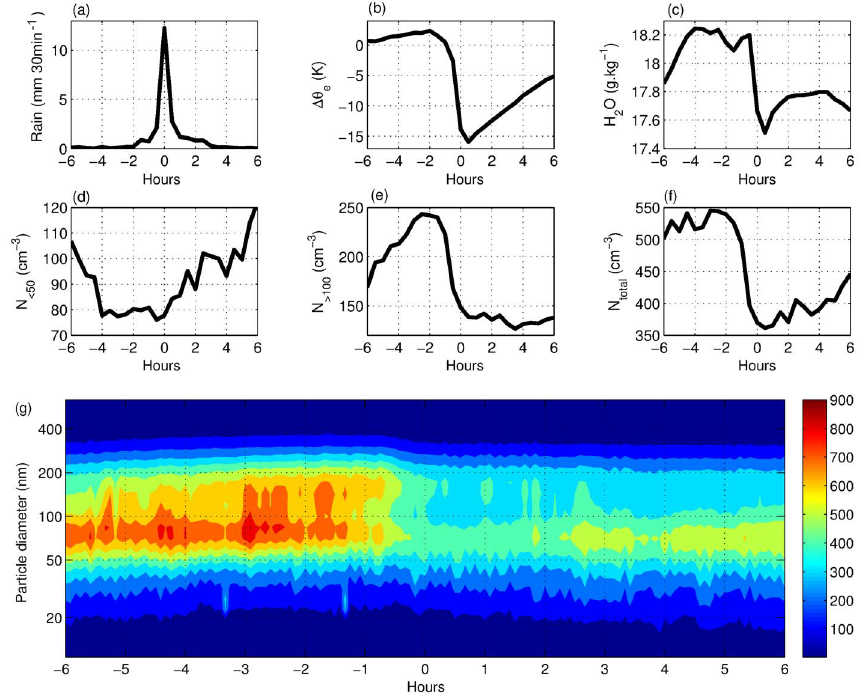
Figure 8. Mean values calculated within ± 6h of the occurrence of strong precipitation events ( > 10mmh − 1 ). Time zero corresponds to the instant of maximum precipitation in each event. Only wet season afternoon events (12:00–16:00LT) were considered in this plot. Top: (a) precipitation (accumulated mm in 30min), (b) variations in equivalent potential temperature ( (cid:49)θ e ), (c) H 2 O mixing ratios. Middle: (d) number concentration of particles with a diameter less than 50nm ( N < 50 ), (e) number concentration of particles with a diameter greater than 100nm ( N > 100 ), (f) total particle number concentration ( N total ). Bottom: (g) contour plot showing mean particle size distributions within ± 6h of precipitation events. The color coding represents particle number concentration normalized by diameter channel, d N/ dlog D p , in cm − 3